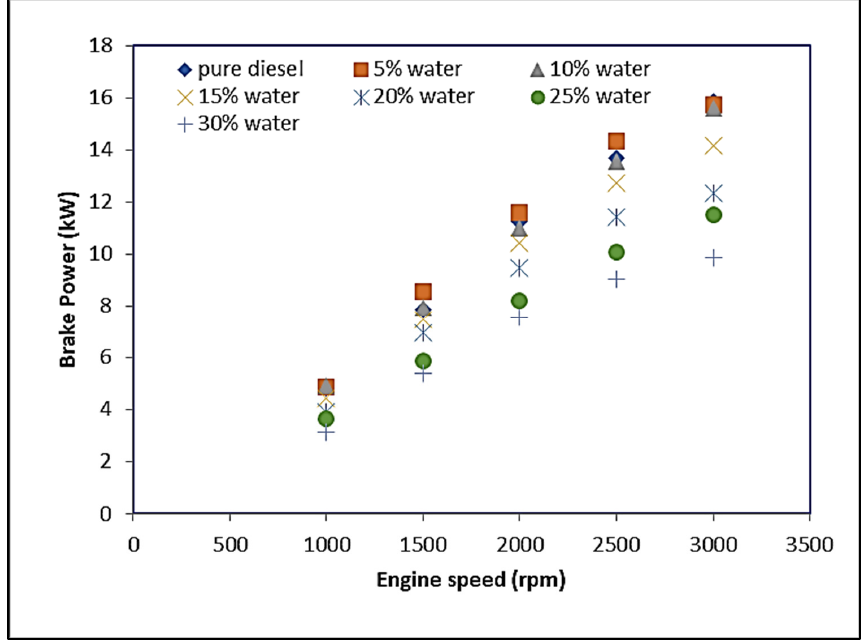
Figure 7. The calorific value (MJ/kg) of different blends of the (W/D) fuel.